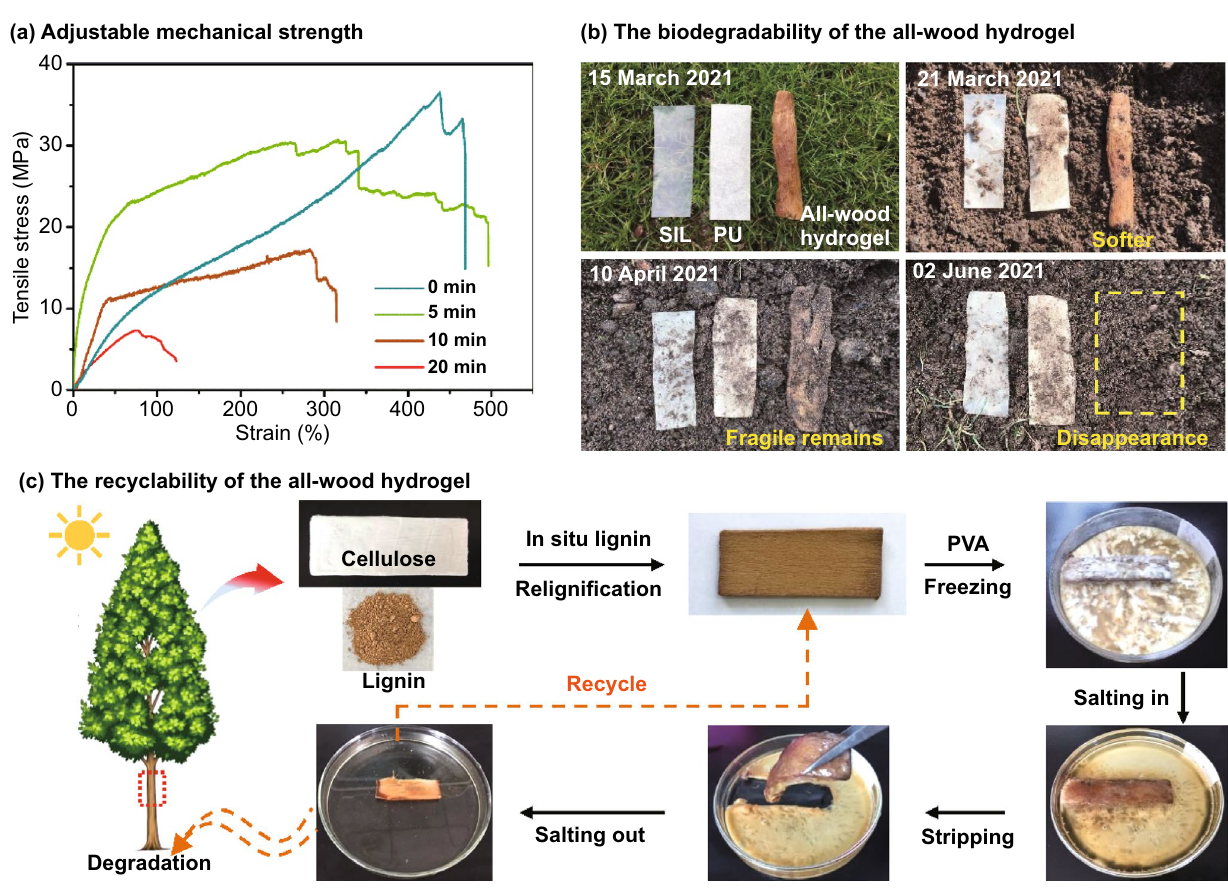
Fig. 7 The mechanical tunability, biodegradability, and recyclability of all-wood hydrogels. a Changes in mechanical strength of the all-wood hydrogels after different salting times. b Biodegradability testing of the all-wood hydrogels and two commercially available silicone (SIL) and polyurethane (PU) adhesive films. c The recyclability of the all-wood